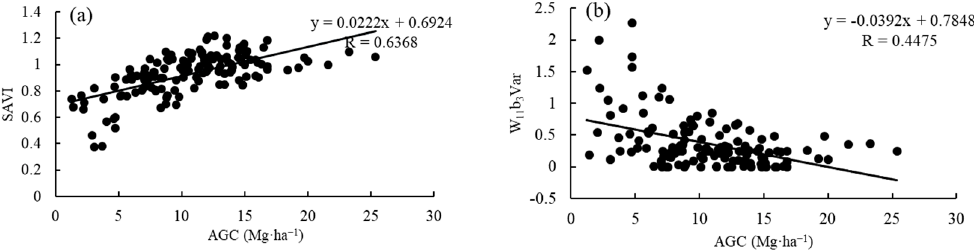
Figure 6. The AGC (Mg · ha − 1 ) versus variables derived from the AGC model of 2004: ( a ) AGC versus SAVI; ( b ) AGC versus W 11 B 3 Var.